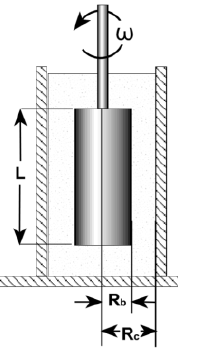
Fig. 6. The spindle and container dimensions [5].